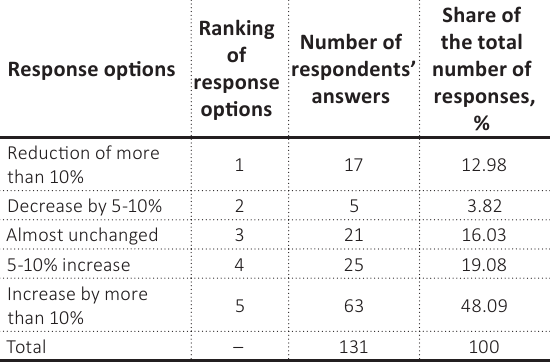
Table 7 systematizes the results of regression anal- ysis for a number of interdependencies. Using